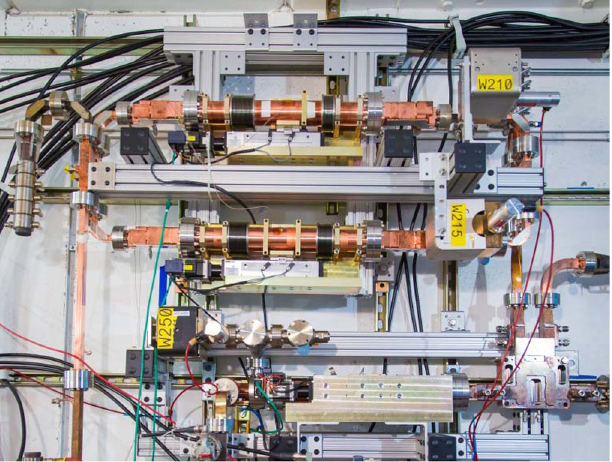
FIG. 4. Three high power phase shifters: the top two (copper cylinders with bellows on each end) are used to adjust the power going to the gun, and the third phase shifter (below the other two) is installed on the branch line that feeds the linac structure (in the photo, it is obscured by a metal support plate). the transmission line that powers the accelerator. In the transmission line feeding the gun, the power is first split by means of a 3 dB hybrid and then each half passes through a phase shifter of the same design as used for the accelerator. hybrid and the power is transported to the gun. These two phase shifters can also be remotely controlled, allowing the phase and amplitude of the gun rf to be varied over a range of 90 degrees in phase and more than 20 dB in power (the unused power is absorbed in a load). The three phase shifters are shown in Fig. 4.